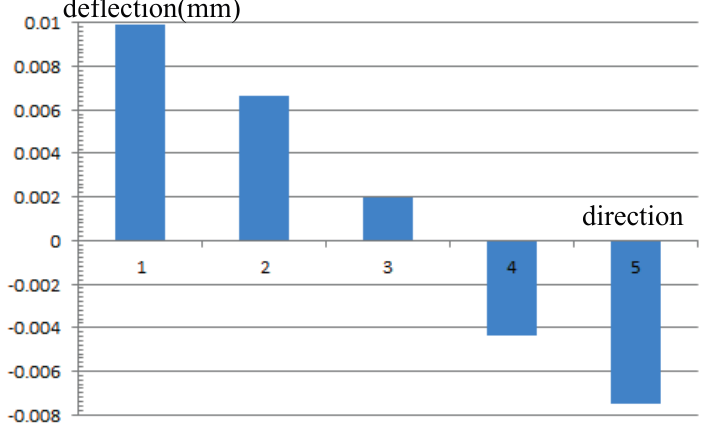
Figure 7. Maximum deflections of the DM surface as the field of view is varied along five directions. The results in Section 3.1 showed dynamic image shift compensation in the constraints of 0.002 mm for 0.1° of rotation in the single mirror case and in the dual mirror case. A smaller deflection of the surfaces was observed in the dual mirror case. In this section, the compensation simulation using the commercial DM was constrained to within 0.0006 mm for one minute of rotation. Compared to other methods currently being used in the field, these results are optimal with an image stabilization accuracy of 0.1 pixels.